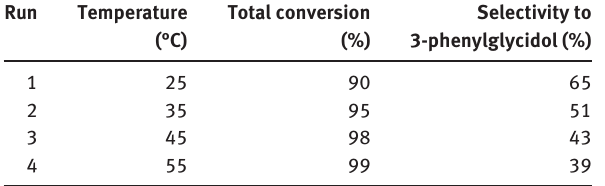
Table 3 Epoxidation reaction of cinnamyl alcohol at different temperatures { 3 mol% of VO(acac) [Tf N] } . 2